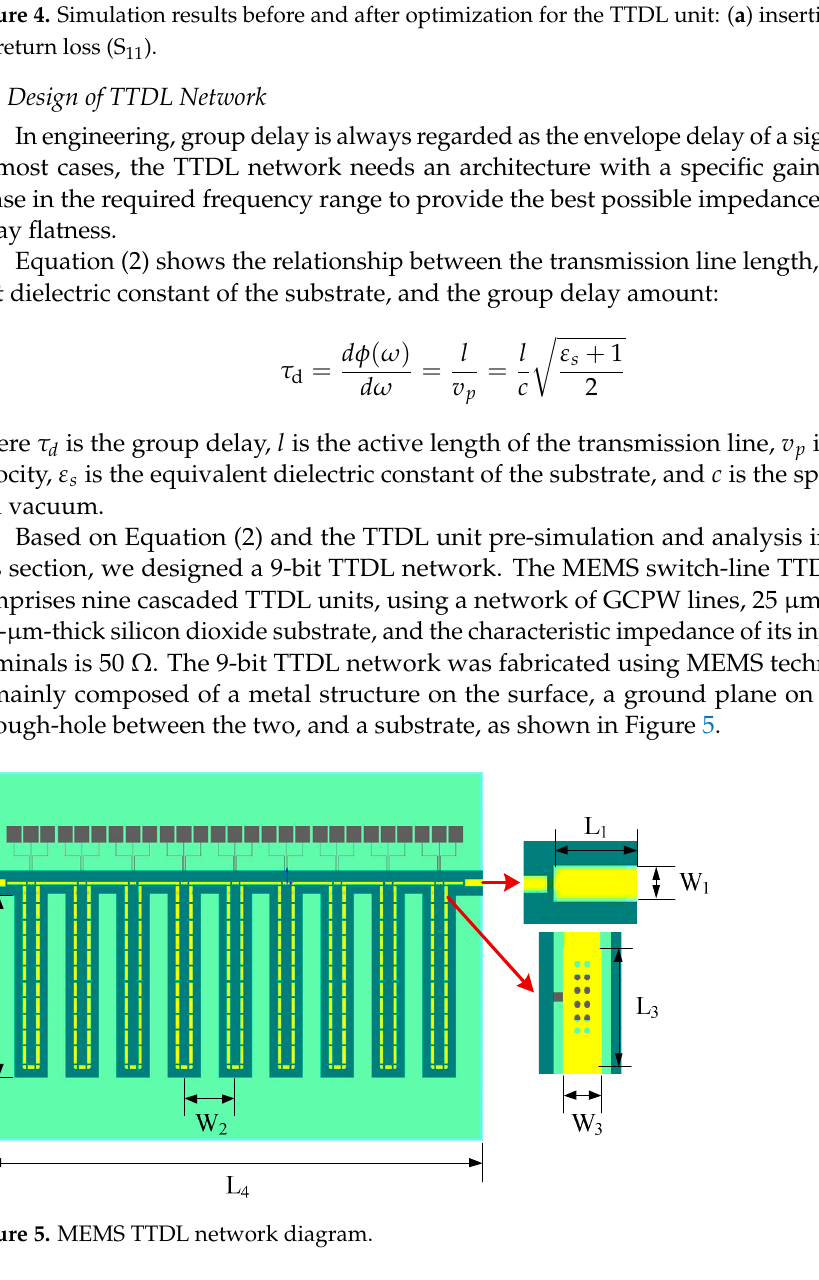
Figure 5. MEMS TTDL network diagram. The structural parameters are shown in Table 2.